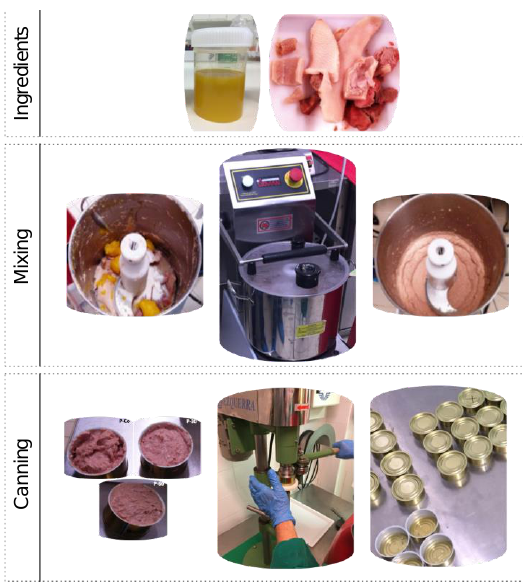
Figure 5. Main stages of pâté production.